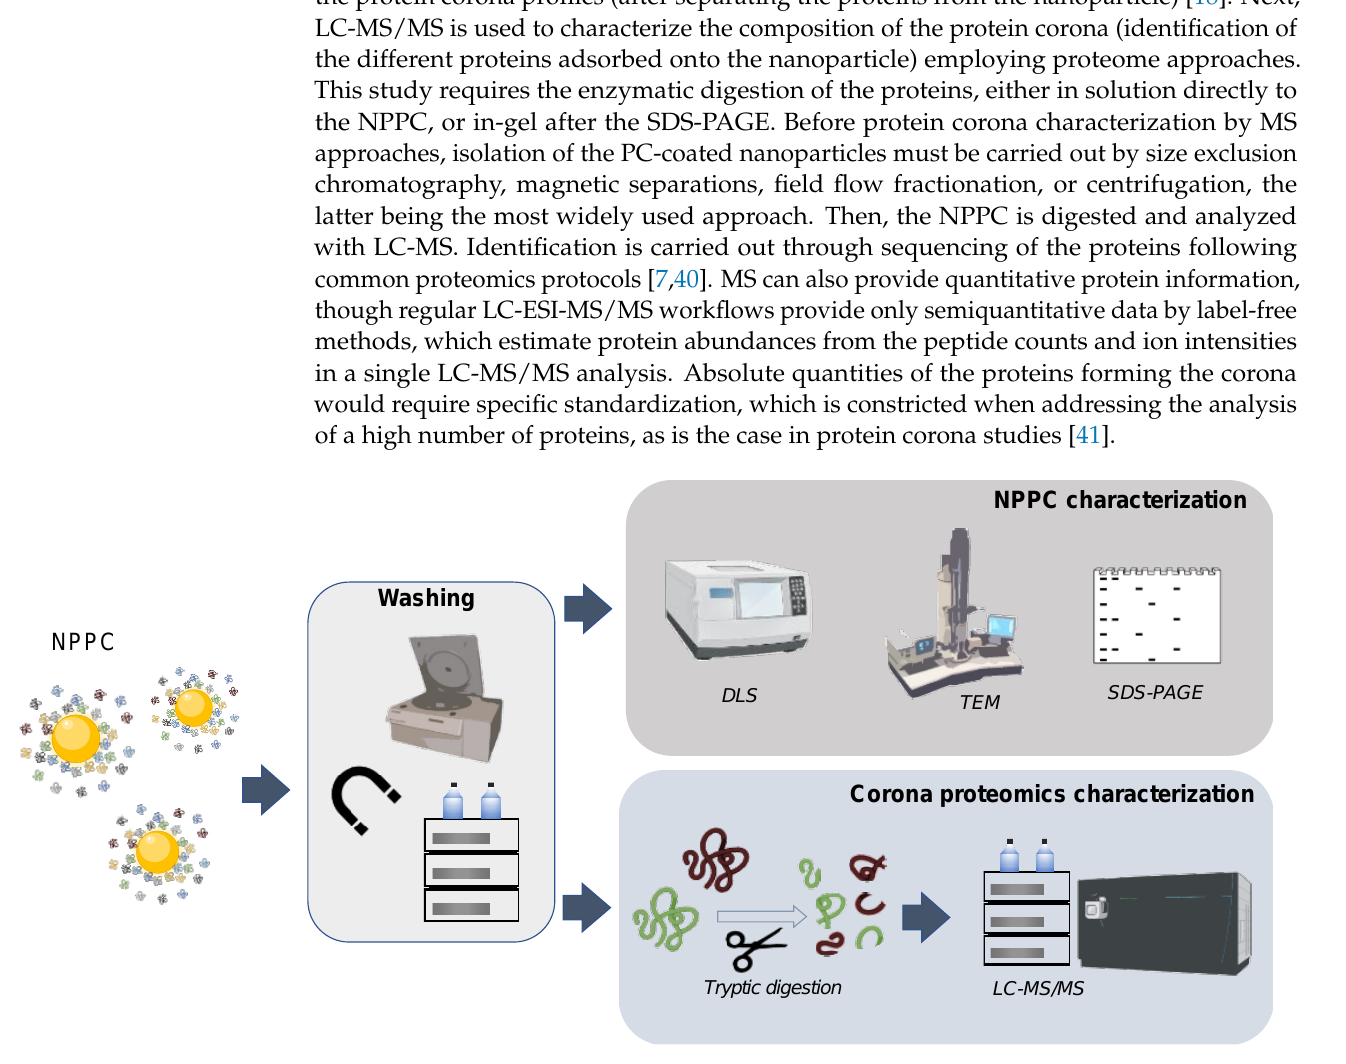
Figure 3. Schematic representation of a typical workflow for the synthesis and characterization of the NPPC.